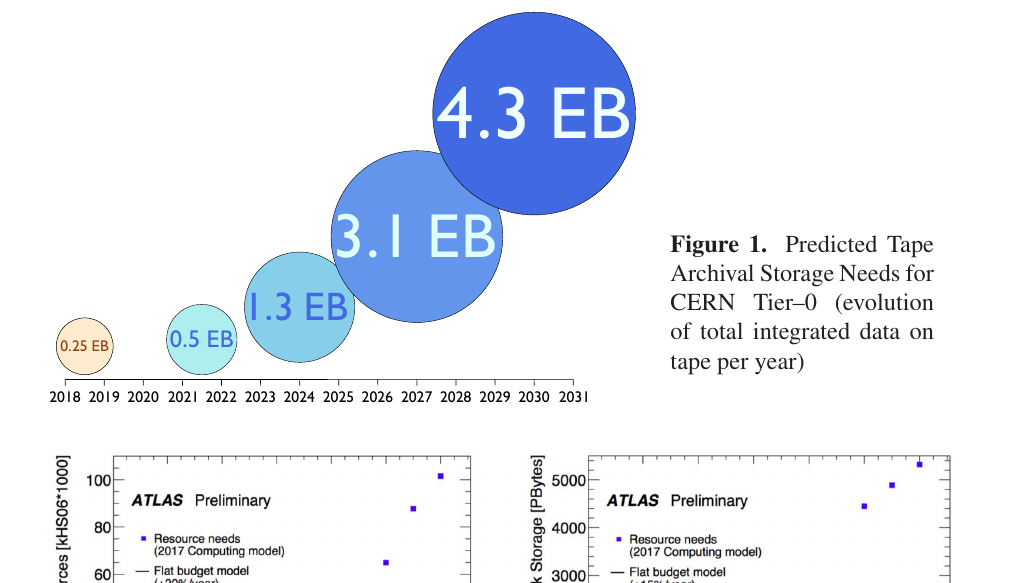
By mid-2018, the total integrated luminosity delivered by the LHC during Run–2